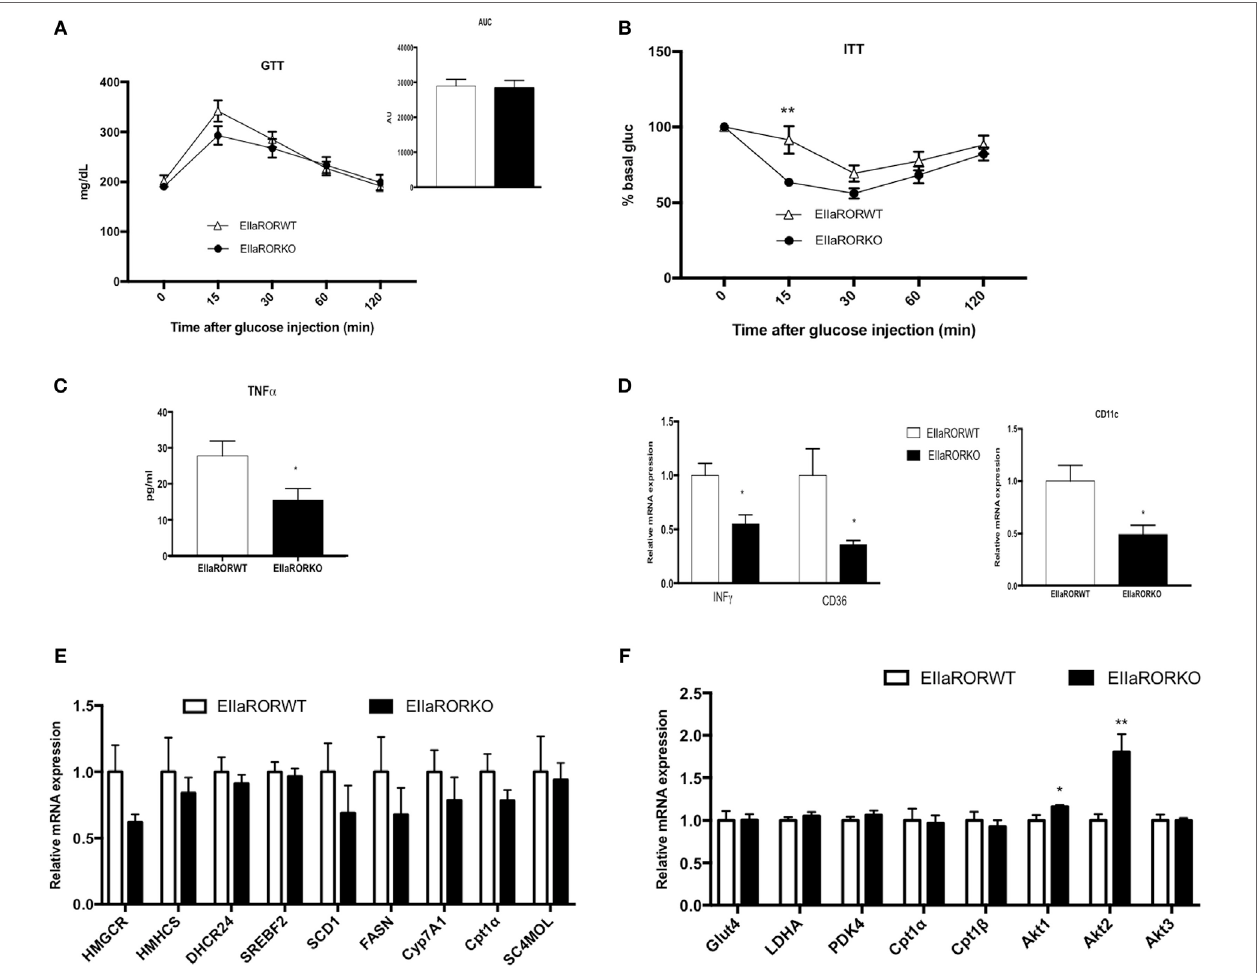
FigUre 4 | EIIAROR α KO mice fed with high fat diet (HFD) display a better glucose homeostasis than EIIAROR α WT mice. (a) Glucose and (B) insulin tolerance test from the same males EIIAROR α WT (white triangle, n = 7) and EIIAROR α KO (black square, n = 7) used in the Figure 3 , fed with HFD for 8 and 9 weeks, respectively. Area under the curve is represented on each graph. (c) Blood TNF α level of the same males EIIAROR α WT (white triangle, n = 7) and EIIAROR α KO (black square, n = 7) fed with HFD for 14 weeks quantified by ELISA. (D) WAT gene expression from the same males EIIAROR α WT (white triangle, n = 7) and EIIAROR α KO (black square, n = 7) fed with HFD for 14 weeks. (e) Liver and (F) muscle gene expression from the same males EIIAROR α WT (white bar, n = 7) and EIIAROR α KO (black bar, n = 7) (* p < 0.05, ** p <